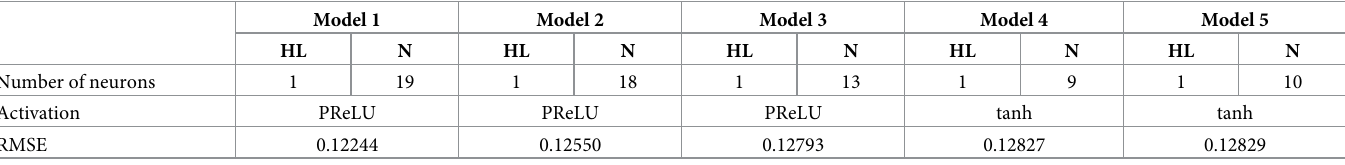
Table 8. Hyperparameter search results summary (Run 1). Top 5 Models out of 250 candidate models from Run